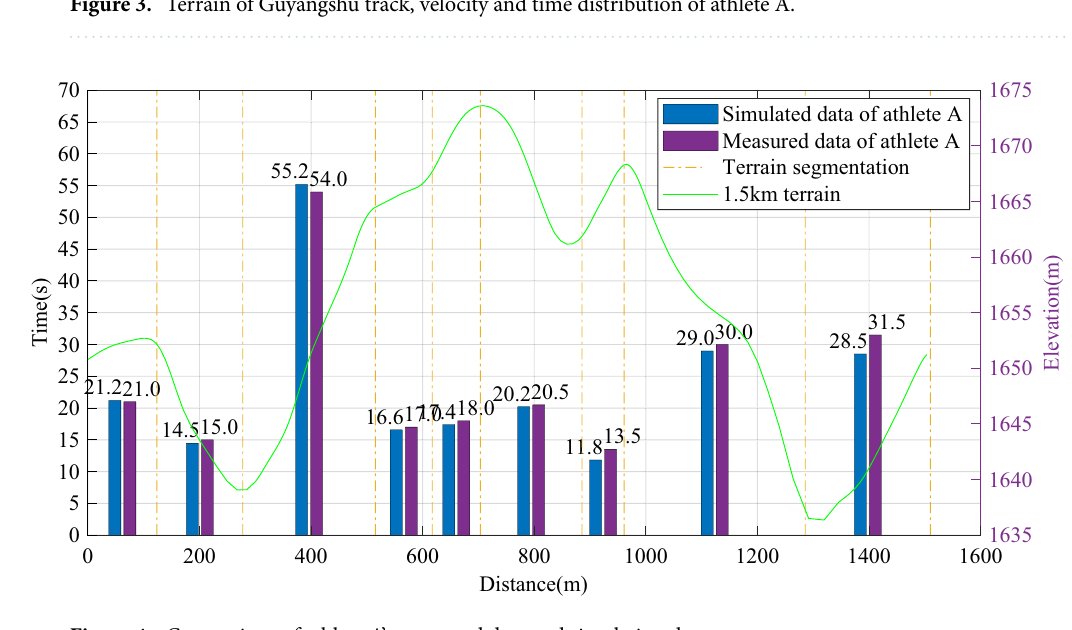
Figure 4. Comparison of athlete A’s measured data and simulation